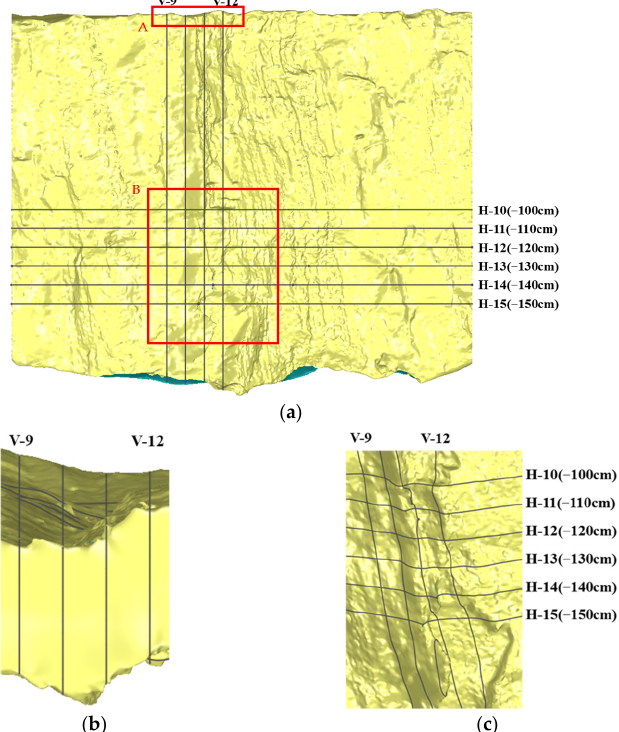
Figure 20. Location and details of the crack bifurcation: ( a ) Front view of crack bifurcation position; ( b ) Top view of position A of Figure 20a ; ( c ) Side view of position B of Figure 20a. At a depth of 130 cm, the crack bifurcation is more evolved (Figure 20c), with a ten- dency to separation. At 150 cm, the separation is ultimately complete and the ground fis- sure forms a groove. Therefore, at depths between 130~150 cm, the ground fissure width exhibits large variations, and at 150 cm the ground fissure width reaches the minimum. The figure shows that the direction of the crack bifurcation is biased towards the in- side of the working face. This is in line with the results of the analysis illustrated in